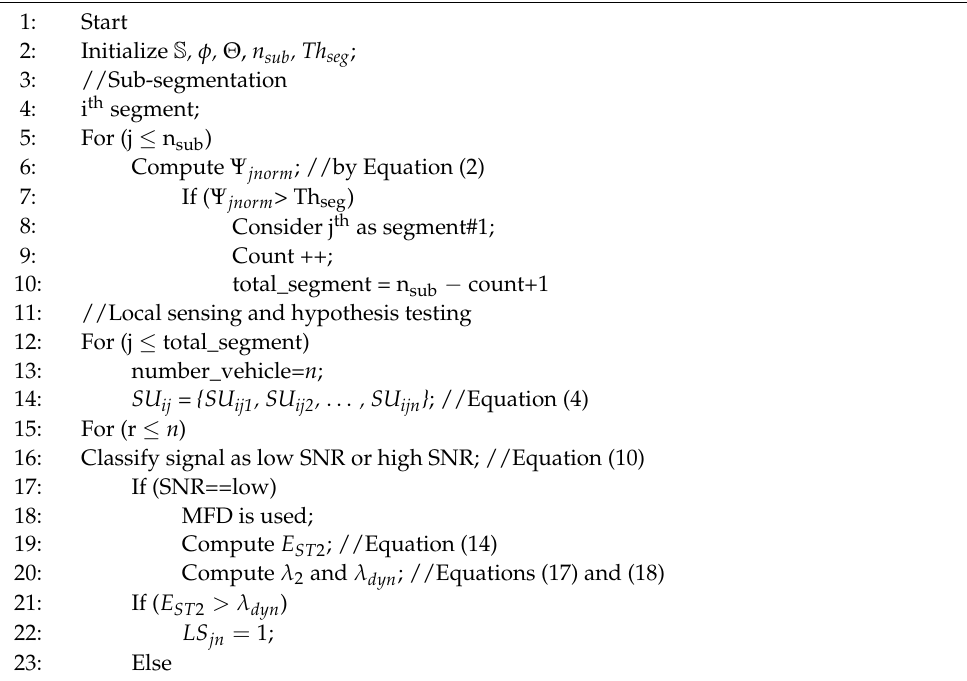
Algorithm 1: Complete algorithm for the